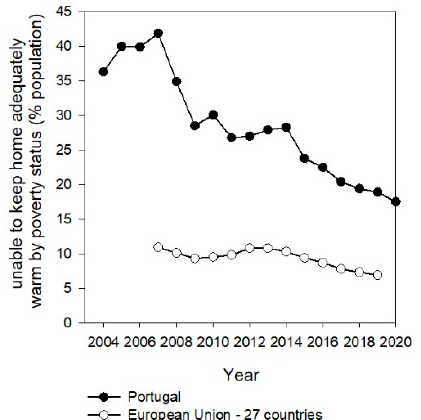
Figure 5. Proportion of inhabitants unable to keep home adequately warm (data source [67]).